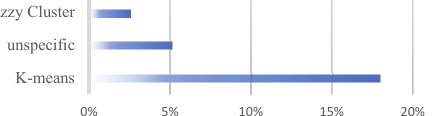
Fig. 6. Comparison of the clustering